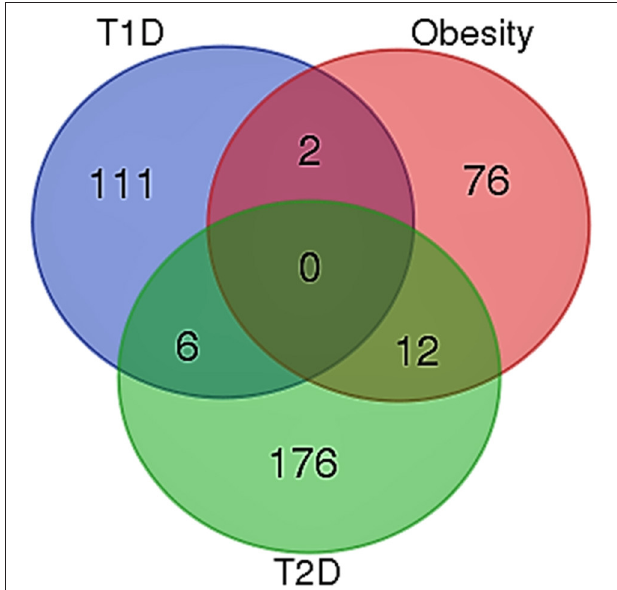
FIGURE 1 | Venn diagram showing the number of genes across the three contexts. Two genes, viz. POMC and ITPR3 have been enriched between T1D and Obesity; six genes, viz. HNF1A, RASGRP1, DLK1, CENPW, GLIS3, and SH2B3 between T1D and T2D; and 12 genes, viz. PROX1, MC4R, ENPP1, TMEM18, FTO, FAM150B, IRS1, PPARG, SPRY2, TCF4, LYPLAL1, and NYAP2 between obesity and